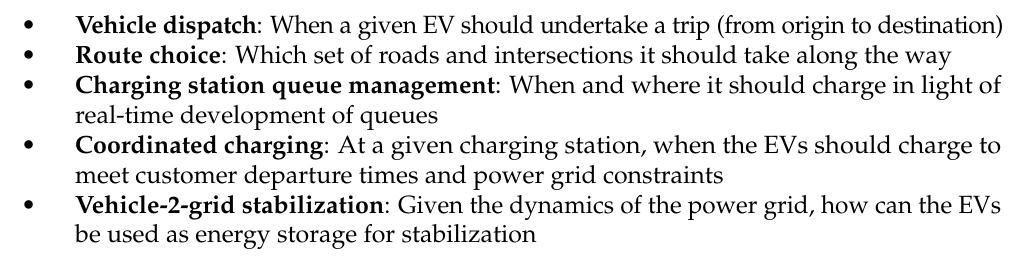
Table 1. Intelligent transportation-energy system operations decisions in the transportation electricity